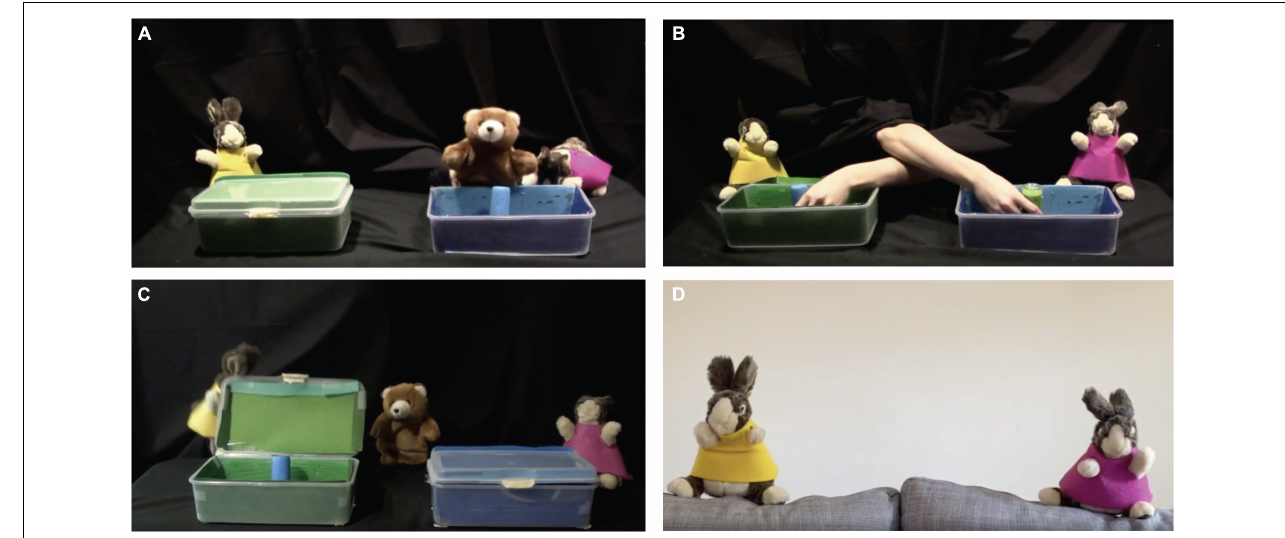
FIGURE 3 | Screenshots of video stimuli implemented in Study 3 (preferential looking, see Woo and Spelke, 2020). (A) Participants were first familiarized to the bear’s preferred toy. (B) The contents of the boxes were then switched either in the rabbits’ presence or absence. (C) One rabbit opened the box where the desired toy was moved to while the other opened the one where the desired toy was originally. (D) At test, infants were shown the two rabbits. In person, infants were asked to choose the one they like and their reach was recorded; online, infants were presented with a video of the two rabbits and their preferential looking was